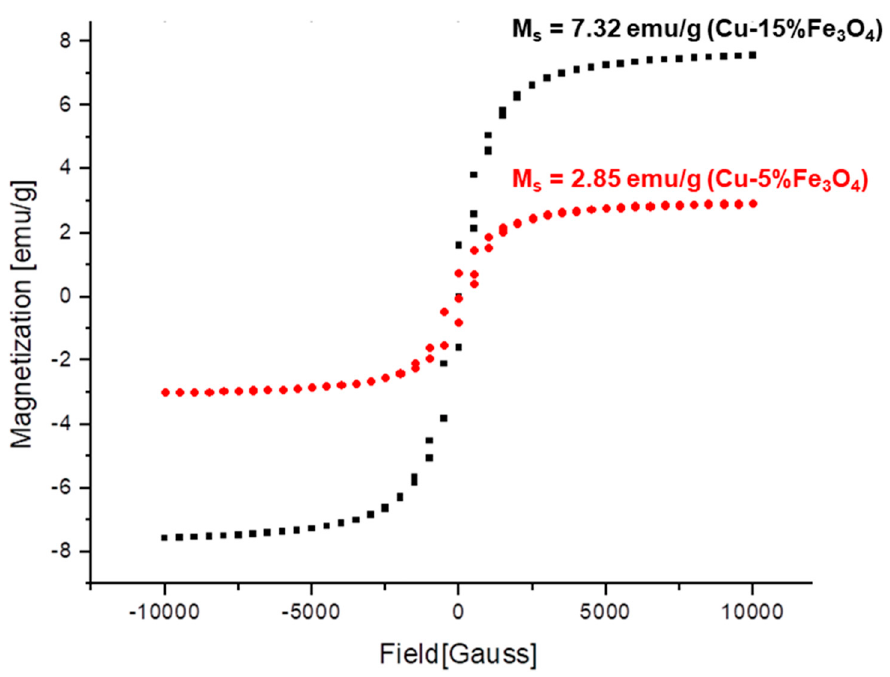
Figure 22. Magnetization curves of Cu-5%Fe 3 O 4 and 15%Fe 3 O 4 nanocomposites performed at room temperature.